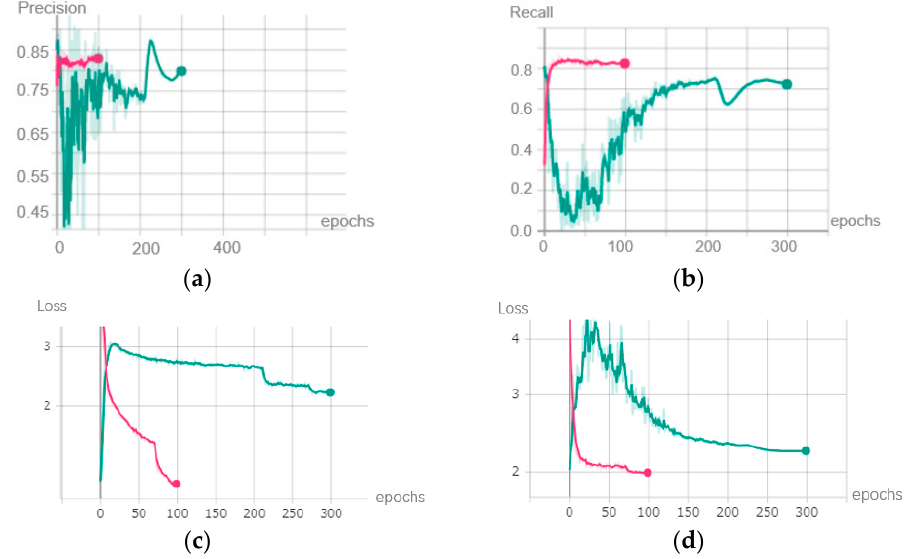
Figure 10. Metrics of the sparsity training stage. ( a ) Precision. ( b ) Recall. ( c ) Loss value of training dataset. ( d ) Loss value of testing dataset.